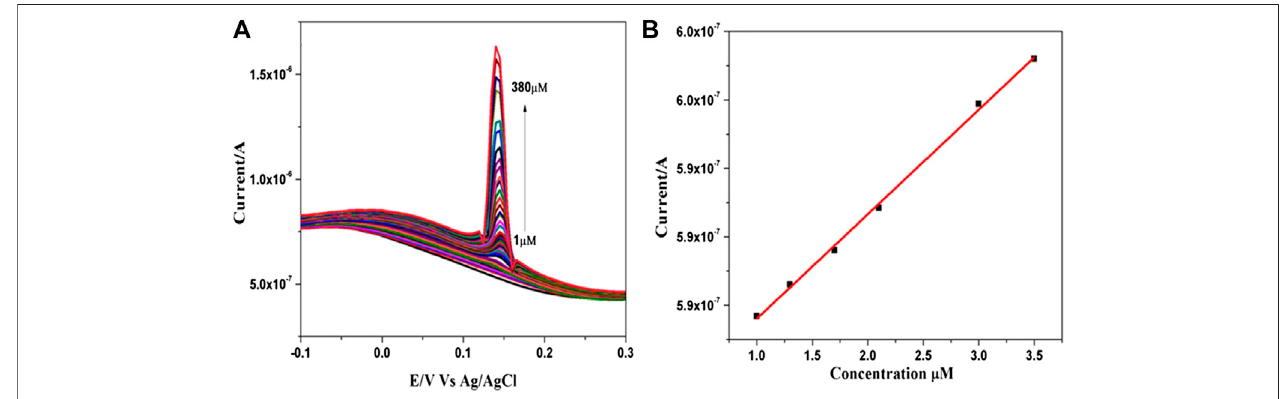
FIGURE 4 | (A) SWVs recorded for various concentration of HgCl2 ranging from 1 to 380 µM in 0.1 M PBS (pH 5.0) at ß-TCP modi fi ed GCE. (B) Corresponding linear calibration